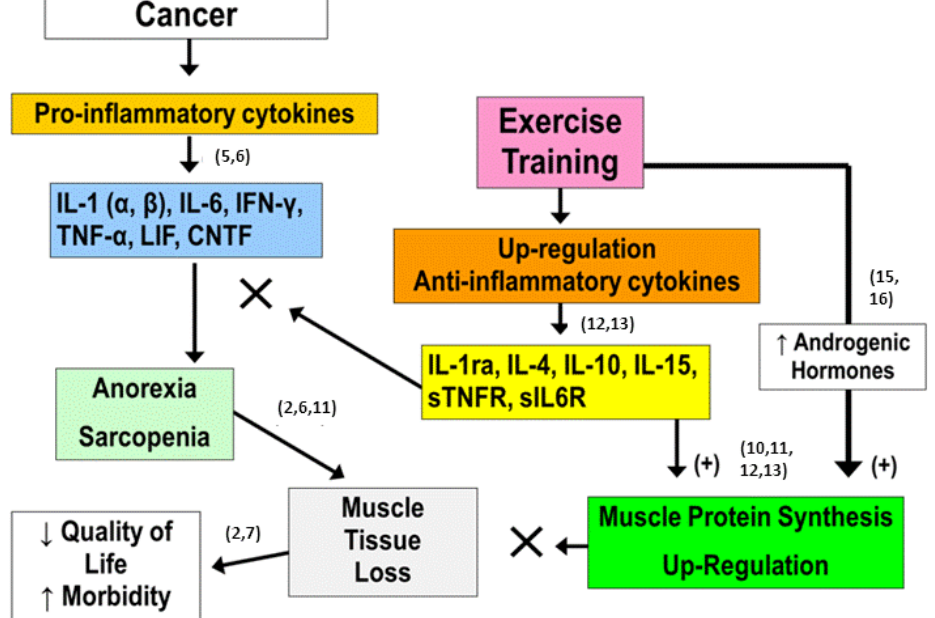
Figure 1. The Exercise Anti-Cachectic Hypothetical (―EACH‖) model of the role exercise training has to facilitate the maintenance or accretion of muscle mass in cancer patients and mitigate the effect of anorexigenic pro-inflammatory cytokines. Numbers in brackets refer to reference